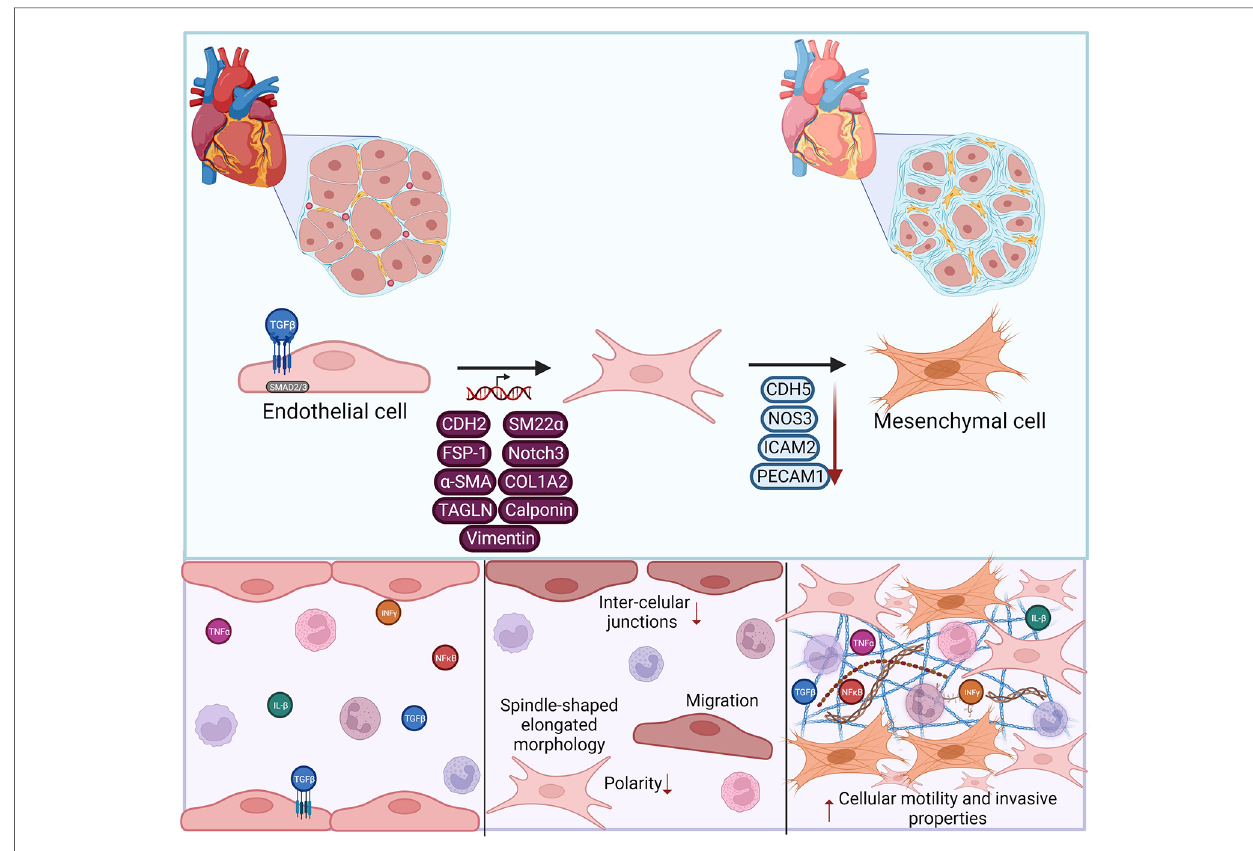
FIGURE 4 Endothelial to mesenchymal transition (EndMT) contributes to vasculopathy. EndMT development is triggered by pro- fi brotic and pro-in fl ammatory stimli, leading to transcriptional modi fi cations in endothelial cells. Gene expression changes lead to phenotypic loss of canonical endothelial markers and gain of mesenchymal features. These EndMT cells can then promote extracellular matrix deposition, and expression of matrix metalloproteases, contributing to vascular remodeling. Made in biorender